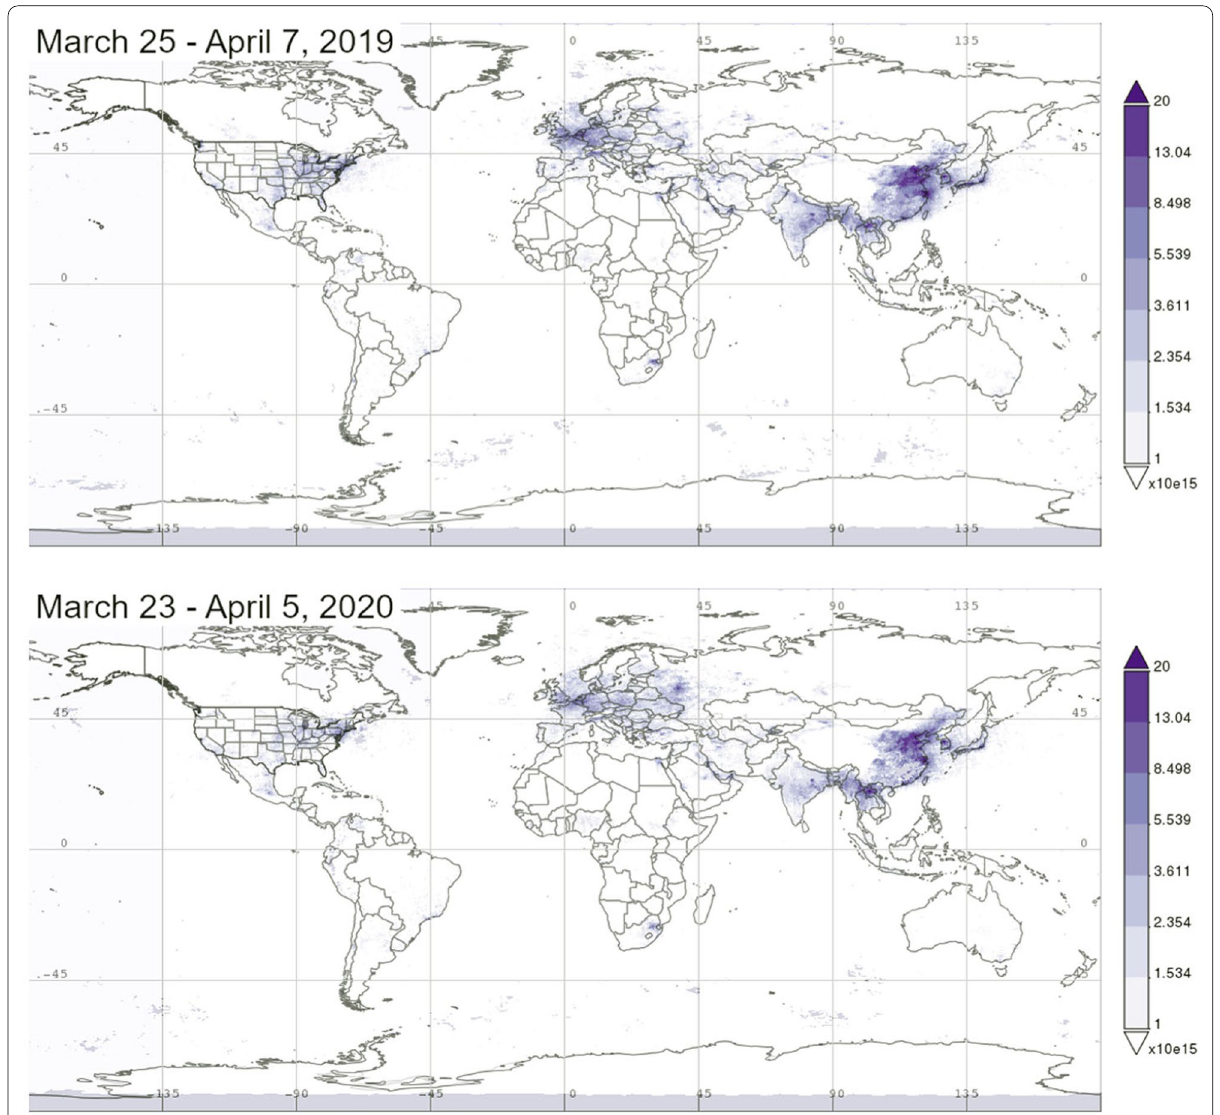
Fig. 3 Nitrogen dioxide (NO 2 ) levels in the troposphere before and after anthropause period. For example, the NO 2 content in Madrid, Milan and Rome decreased by about 45%, and by 54% in Paris, compared to 2019. From Copernicus Sentinel data 2019–2020 processed by